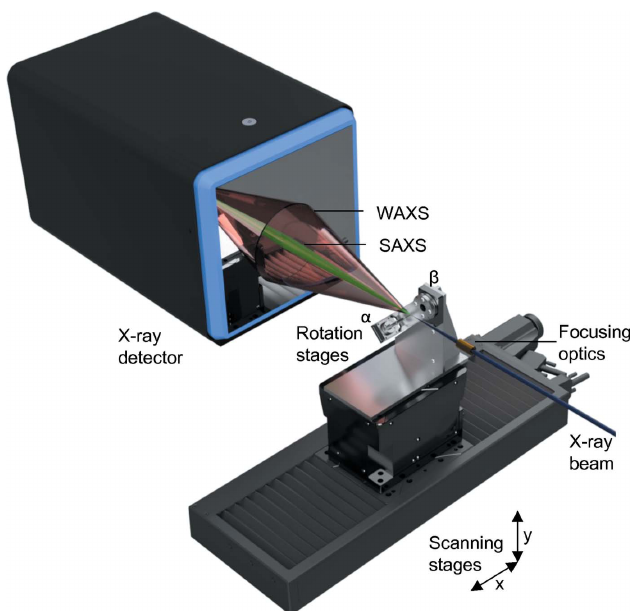
Figure 1 Experimental setup of SAXS/WAXS tensor tomography. An X-ray beam is focused on the sample by a set of compound refractive lenses. The sample is scanned through the beam by a set of xy scanning stages at various rotation and tilt angles around (cid:3) and (cid:2) . A full SAXS/WAXS pattern is collected at every point of the scan and used for the data